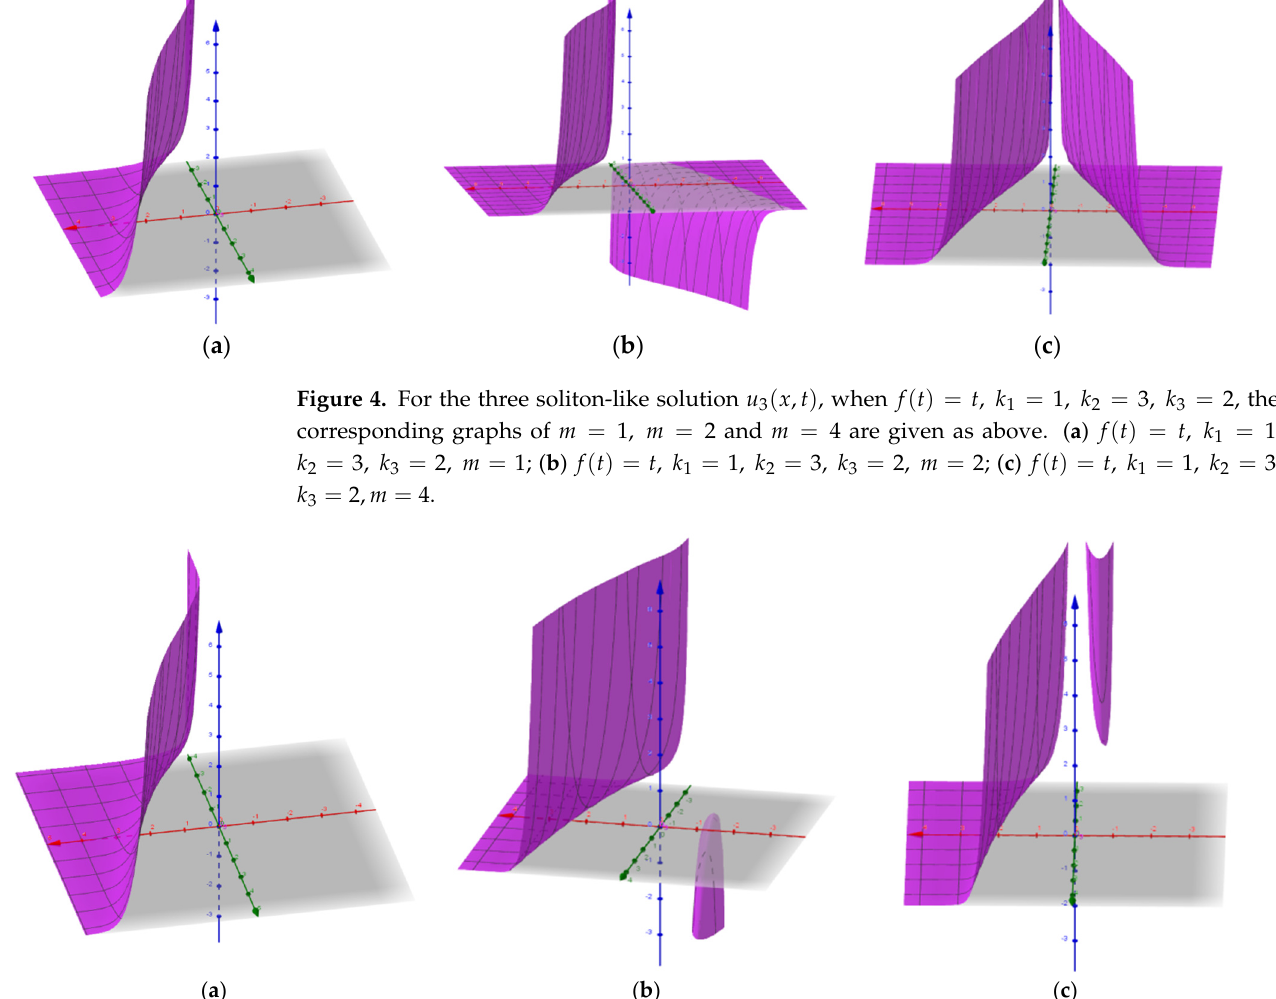
Figure 5. For the three soliton-like solution u 3 ( x , t ) , when f ( t ) = t 2 , k 1 = 1, k 2 = 3, k 3 = 2, the corresponding graphs of m = 1, m = 2 and m = 4 are given as above. ( a ) f ( t ) = t 2 , k 1 = 1, k 2 = 3, k 3 = 2, m = 1; ( b ) f ( t ) = t 2 , k 1 = 1, k 2 = 3, k 3 = 2, m = 2; ( c ) f ( t ) = t 2 , k 1 = 1, k 2 = 3, k 3 = 2, m = 2 .